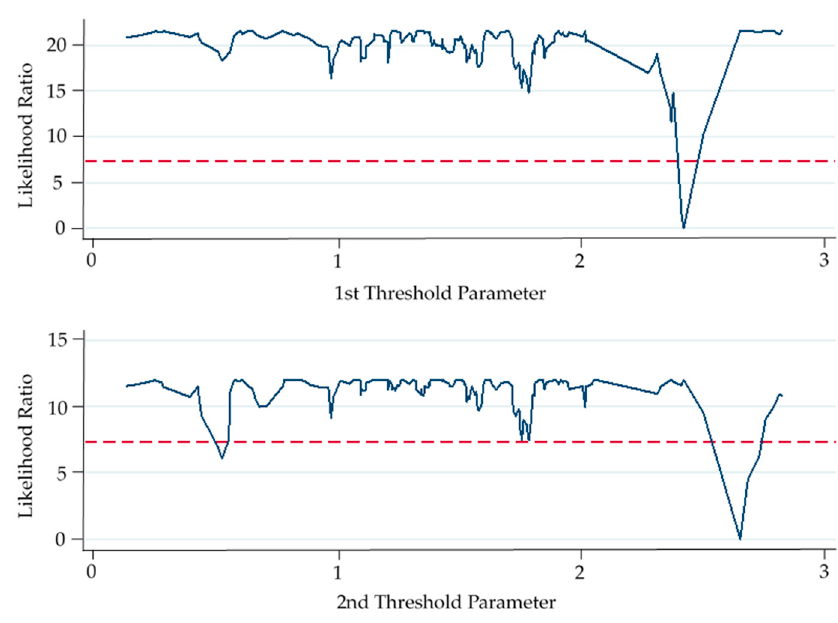
Figure 3. Double threshold regression LR test residuals (ln mi ).